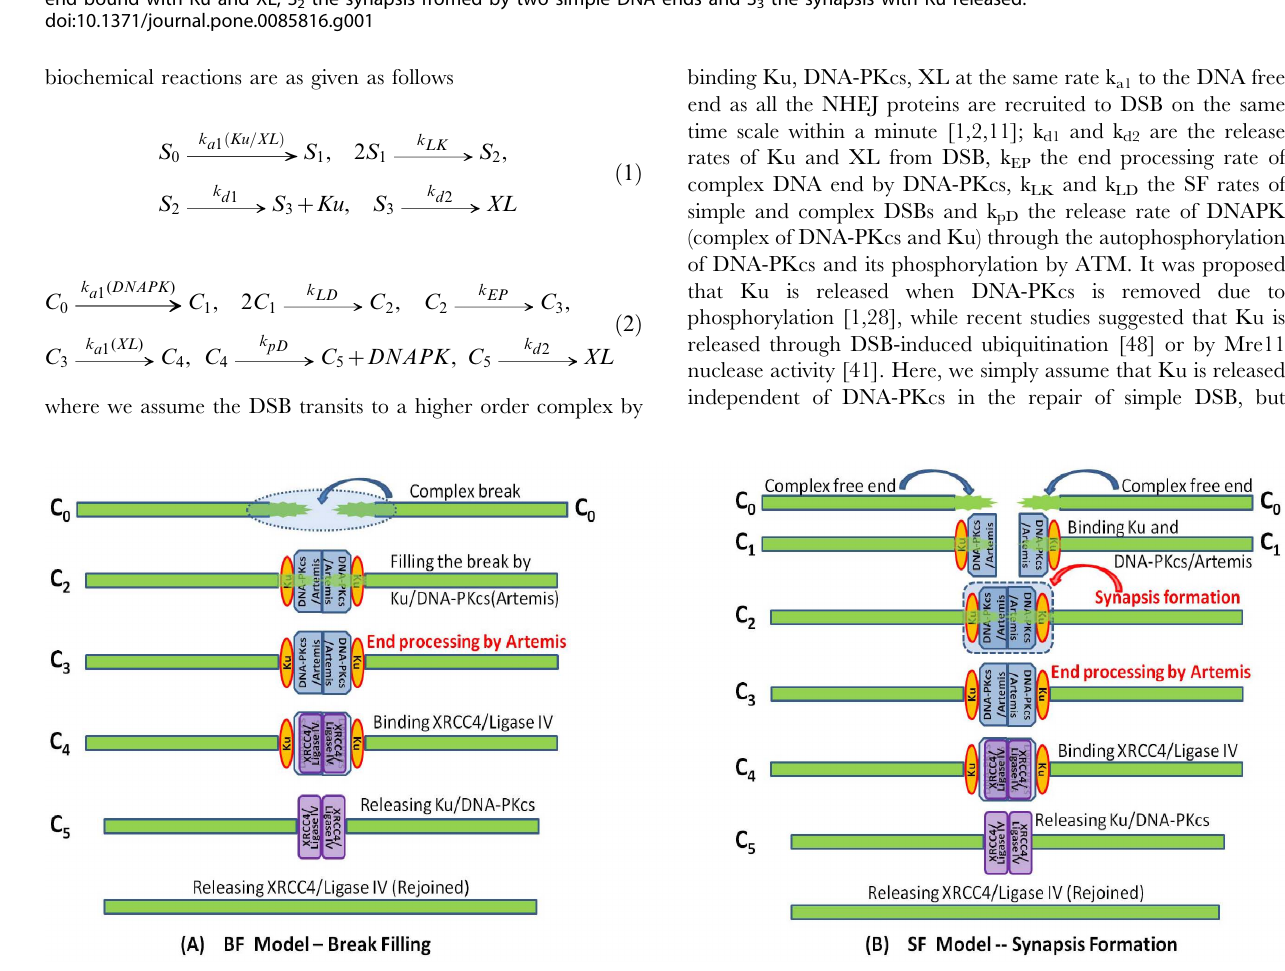
Figure 2. Modeling the repair of complex DNA double strand breaks. DSBs repair can be modeled in terms of either: (A) break filling in which C 0 represent the complex break, C 2 the break filled by Ku and DNA-PKcs/Artemis and C 3 the filled break after end processing by Artemis, C 4 the filled break bound with XL, and C 5 the filled break with Ku and DNA-PKcs released; or (B) synapsis formation in which C 0 represent the complex free DNA end, C 1 complex DNA end bound with Ku and DNA-PKcs/Artemis, C 2 the synapsis fromed by two complex DNA ends, C 3 the synapsis after end processing by Atemis, C 4 the synapsis with XL recruited, and C 5 the synapsis with Ku and DNA-PKcs released.